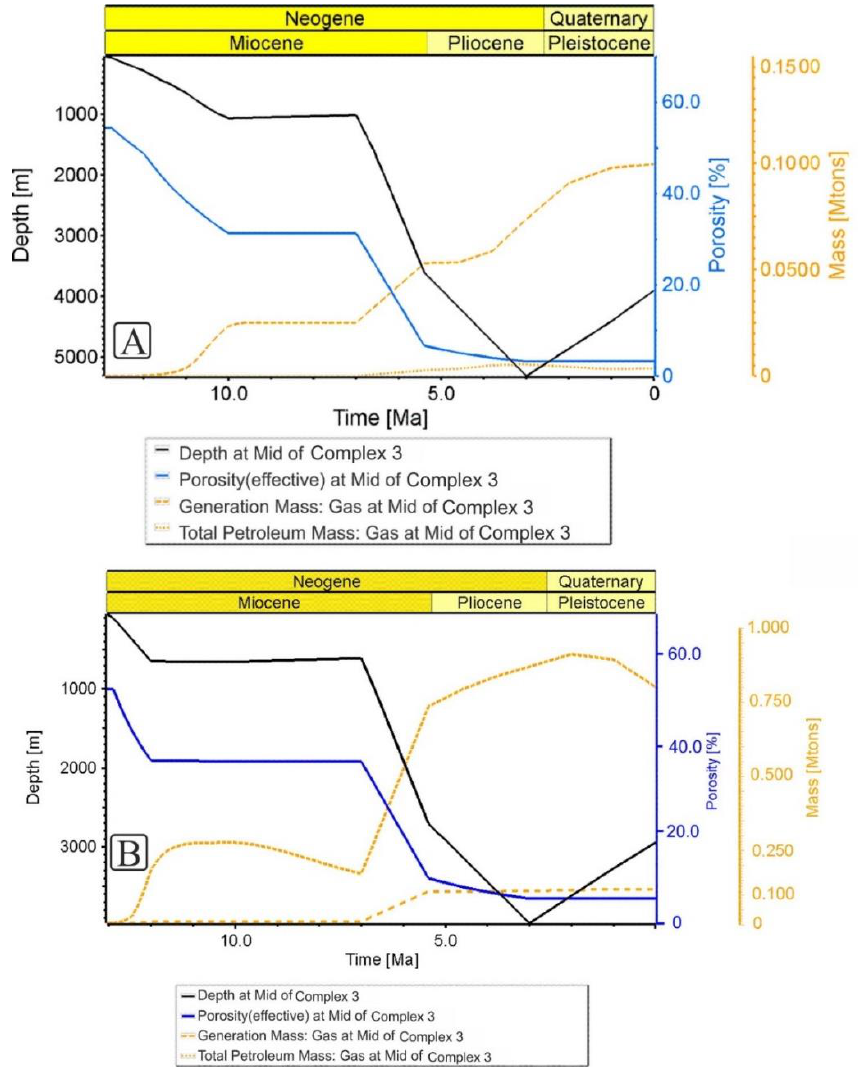
Figure 16. Comparison of diverse gas accumulation conditions (marked as total petroleum mass curve) in Miocene mudstones within Complex 3 located beneath the Carpathian Orogen, at burial depths about 3000–4000 m: ( A ) Location within Complex 3 with unfavorable accumulation conditions; ( B ) location within Complex 3 with favorable accumulation conditions. Values of generated and accumulated hydrocarbons refer to the area of 700-m × 700-m calculation block of the model and 100-m thickness of sediments.